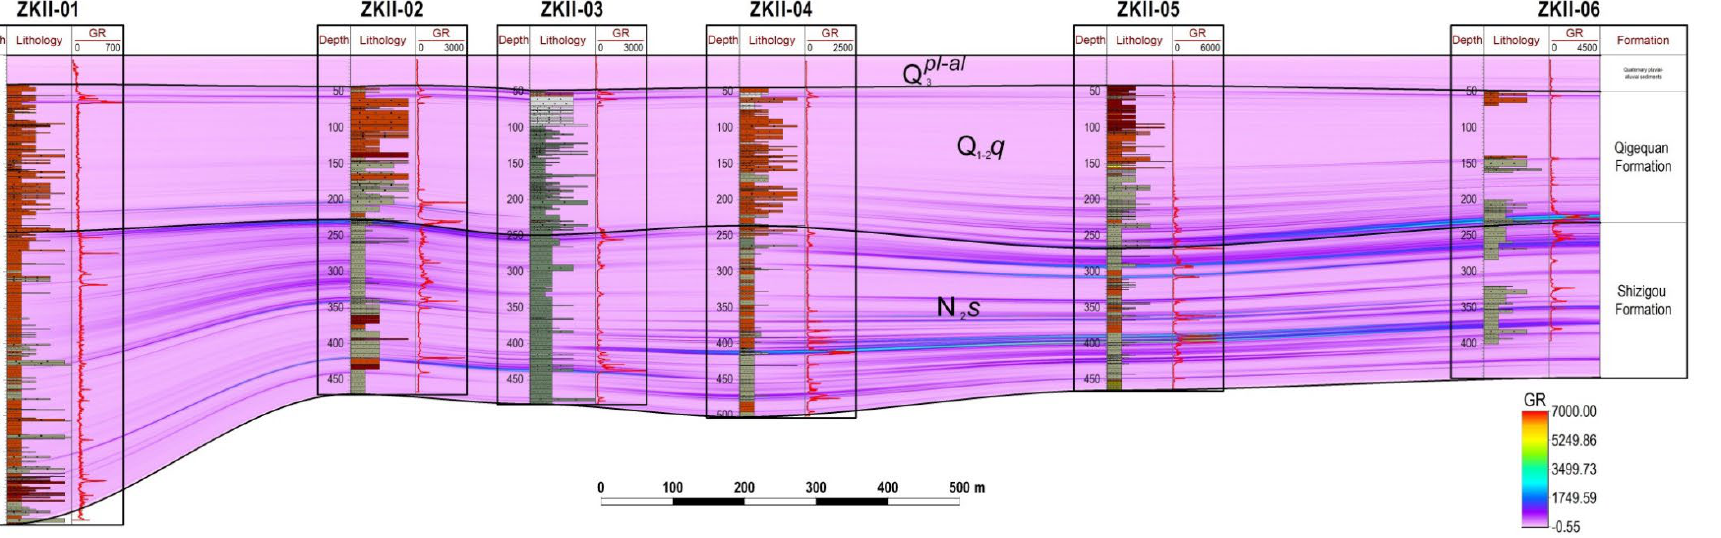
Figure 4. The well-tie profile to illustrate uranium ore horizons among industrial sandstone-hosted uranium boreholes in the Yuejin-II area (the contour-filled color was based on the Natural Gamma Logging Values (GR), with high values representing the uranium horizons). Q 3 pl-al -Quaternary pluvial-alluvial sediments, Q 1-2 q -Quaternary Qigequan Formation, N 2 s -Neogene Shizigou Formation.